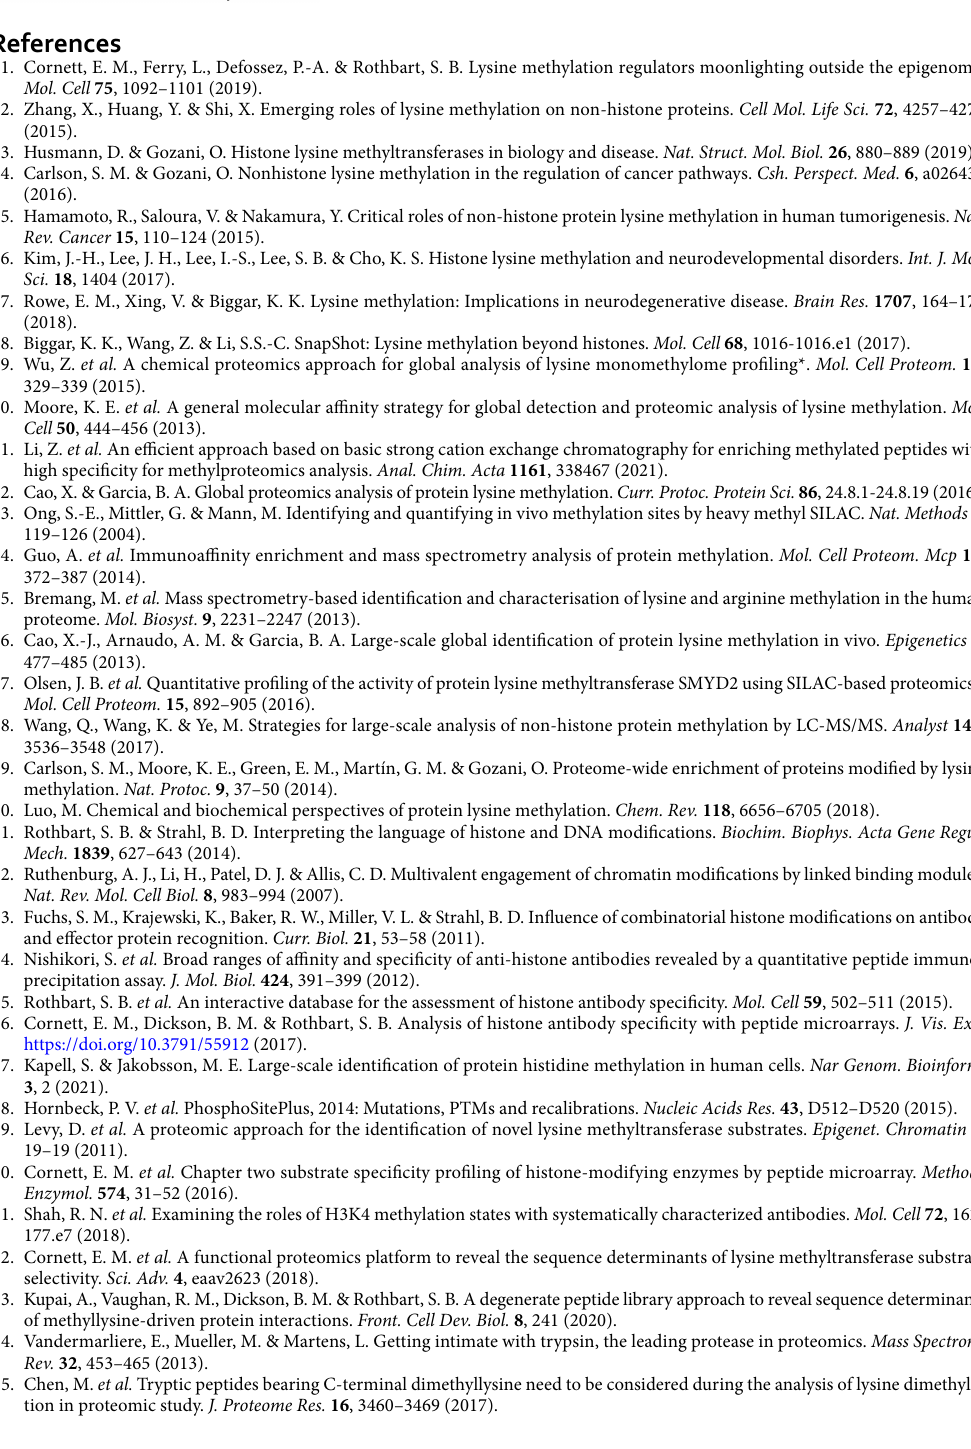
tal Table 3). The frequency scores of the amino acid were summed for each individual 7-mer peptide with a central lysine in the human proteome, thereby giving a score for all lysine centralized 7-mer peptides in the human proteome. The output is a ranked list of preferred peptides from each of the 10 antibodies based on the K-OPL data. Data